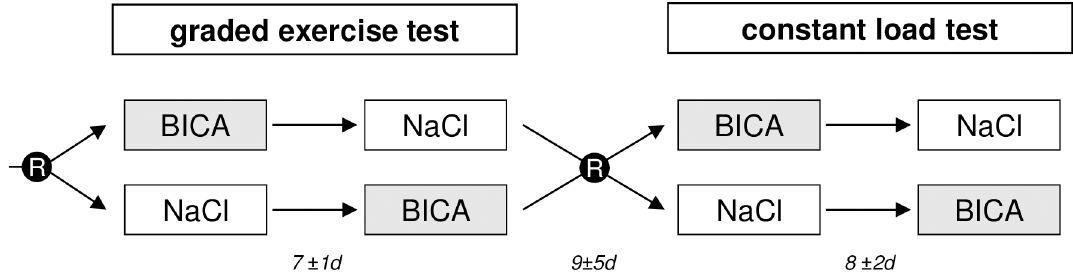
Fig 2. General study design. Subjects were randomly allocatedbefore both the gradedexercise and the constant load test. Both test protocols were conductedafter ingestionof either 0.3 g/kg BICA or 4 g placebo(NaCl). Time intervals betweenthe tests are presented as means ± SD. R in black circle =